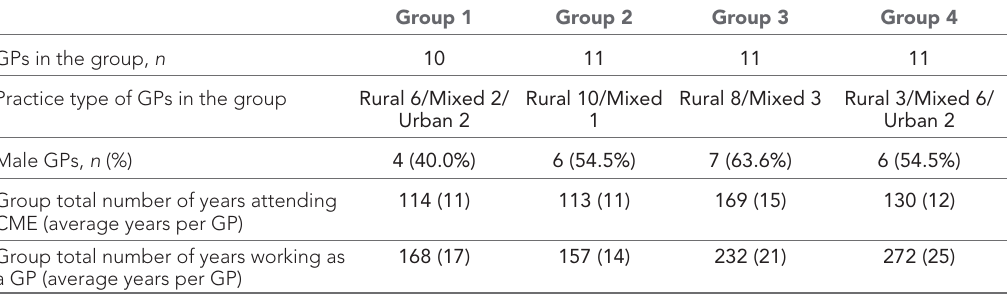
Table 1 GP experience (in years) of four CME-SGL groups GPs in the group, n Practice type of GPs in the group Rural 6/Mixed 2/